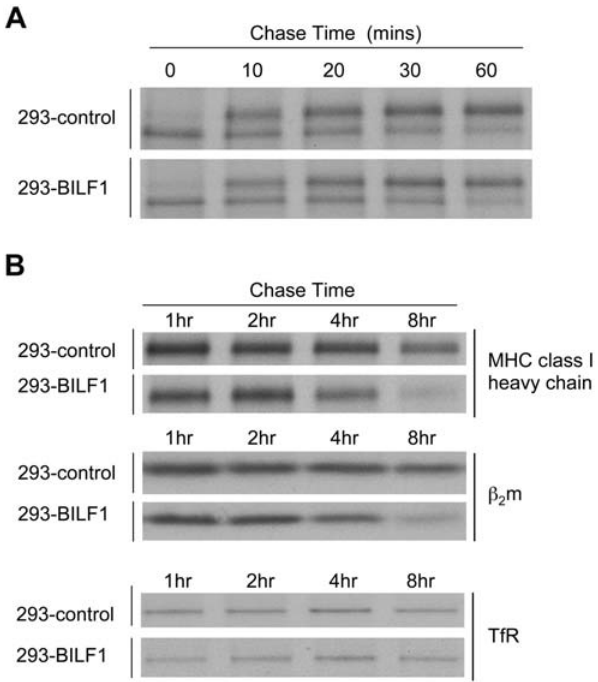
Figure 5. Effect of BILF1 on maturation and degradation of MHC class I molecules. ( A ) Acquisition of endoglycosidase H (Endo H) -resistance of MHC class I heavy chain. 293 cells (2 6 10 6 ) stably transduced with control or BILF1 retrovirus were metabolically labeled for 15 min with 35 S-methionine/cysteine and chased for the indicated time periods. After lysis in NP-40 detergent buffer, samples were immunoprecipitated with mAb W6/32 and treated with Endo H enzyme. Protein samples were separated by 10% acrylamide SDS/PAGE gel, dried and exposed to autoradiography. ( B ) Kinetics of MHC class I molecule degradation. 293 cells (2 6 10 6 ) stably transduced with control or BILF1 retrovirus were metabolically labeled for 15 min and chased for the indicated time periods. After lysis in NP-40 detergent buffer, samples were immunoprecipitated with mAb W6/32 (HLA class I heavy chain and b 2 -microglobulin) or H68.4 (TfR). Protein samples were separated by 10% SDS/PAGE gel, dried and exposed to autoradiogra- phy.